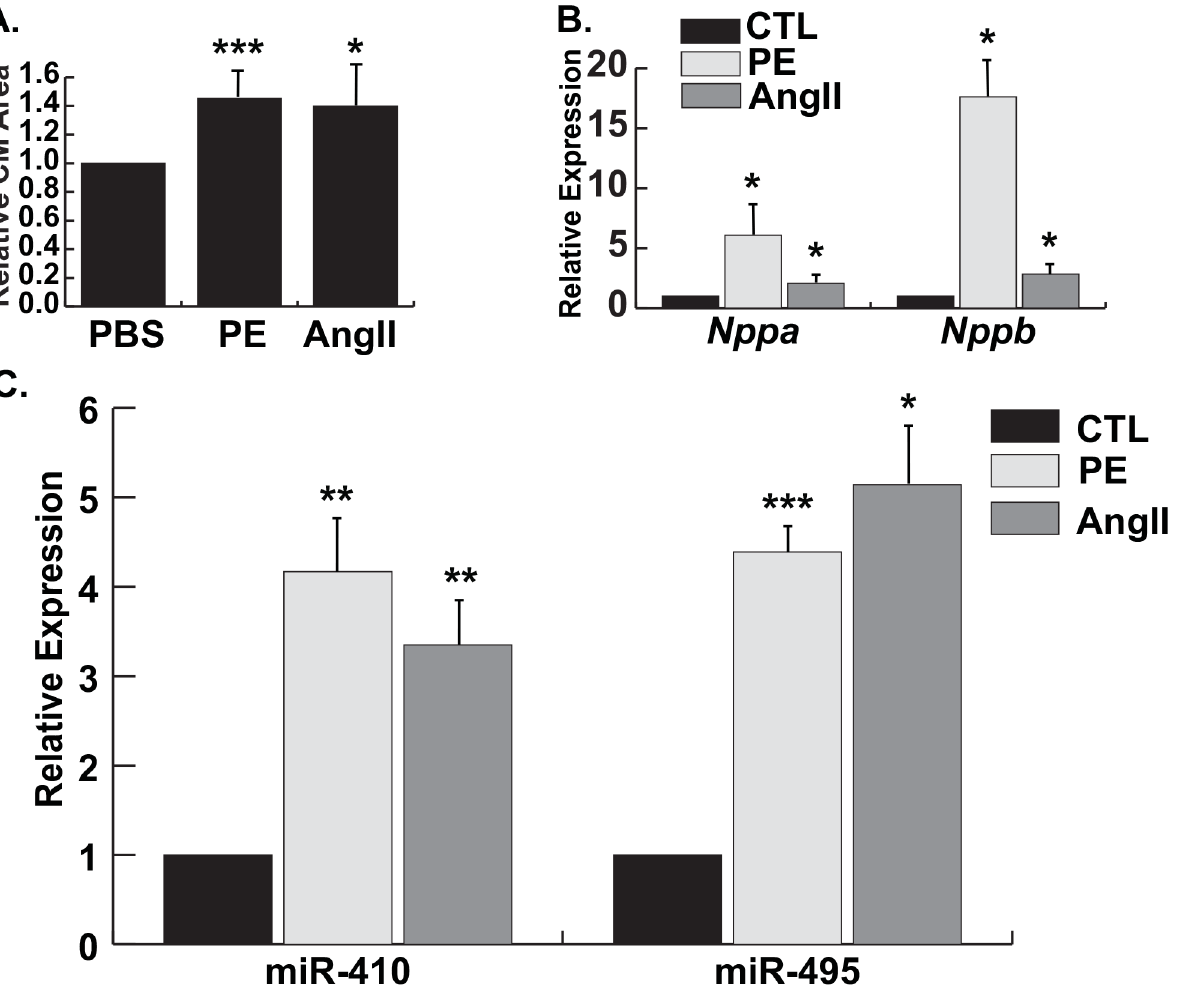
Fig 2. Gtl2-Dio3 miRNAs are upregulated in vitro in cardiac hypertrophy. A , Relative cardiomyocyte (CM) area in control (PBS), phenylephrine-treated (PE), and angiotensin II-treated (Ang II) NRVMs. B , Quantitative RT-PCR expression of the hypertrophic markers Nppa and Nppb in PE- and Ang II-treated NRVMs. Values are normalized to PBS control (CTL). C , Quantitative RT-PCR expression of miR-410 and miR-495 in PE- and AngII-treated NRVMs, respectively. Error bars represent mean ± S.E. * , p < 0.05; ** , p < 0.01; *** , p <